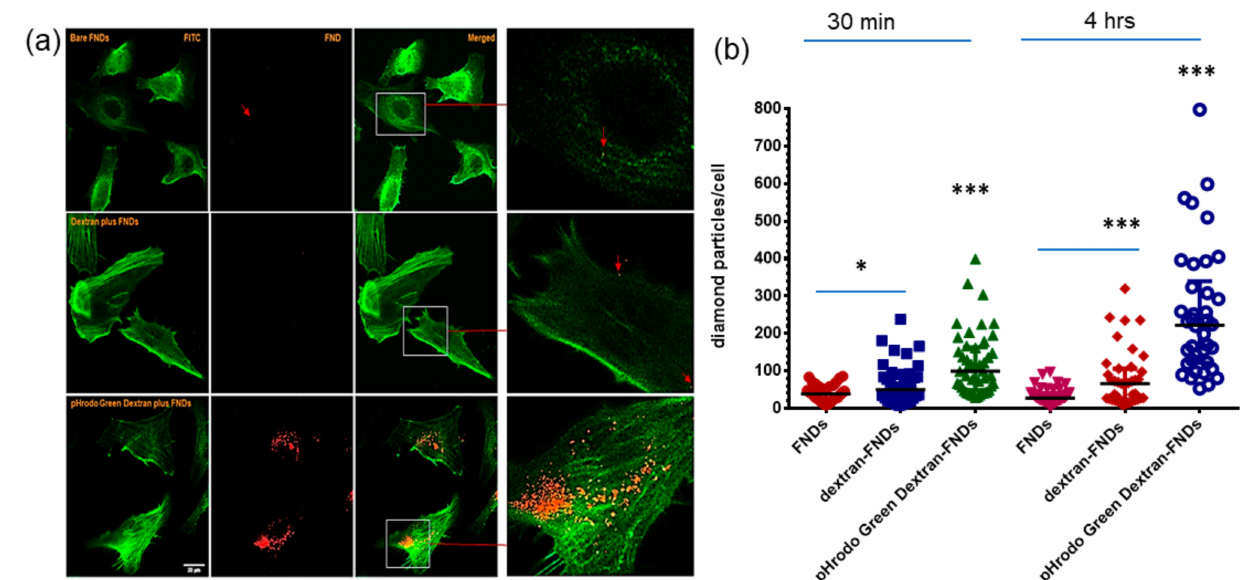
Figure 4. Cellular uptake of diamond particles. ( a ) Confocal images of HeLa cells uptake FNDs, cells incubated with diamond particles for 4 h. green: pHrodo Green Dextran, DIC: Differential interference contrast, red: FNDs, the arrow indicates a diamond position diamond signal, scale bar: 20 µ m. Arrows and zoomed in images used to indicate diamond location. ( b ) Analysis of diamond numbers in cells incubated with diamond particles for 30 min and 4 h. Three independent experiments were performed, 100 cells were counted for each group: bare FNDs, dextran plus FNDs, dextran-blocked cells first, pHrodo Green Dextran plus FNDs. * p < 0.05, *** p < 0.0001 as significant